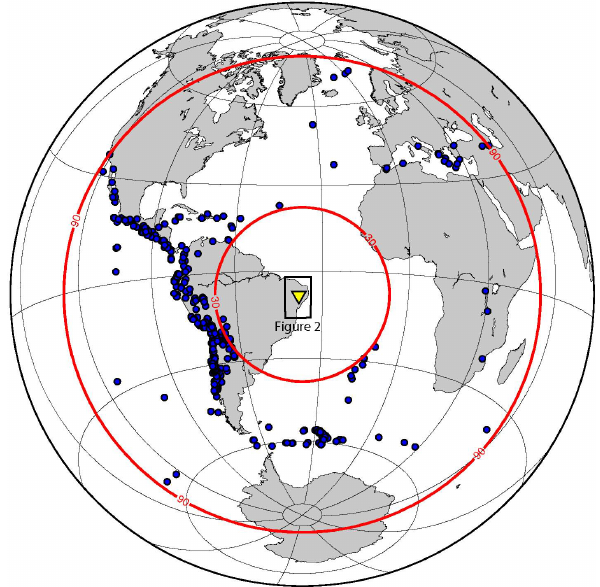
Figure 3. Location of earthquakes (blue circles) used for receiver function analyses, occurring at epicentral distances between 30 and 90 ◦ (red lines) and with a magnitude of M b ≥ 5 . 0. The yellow tri- angle corresponds to the seismic network presented in Fig.